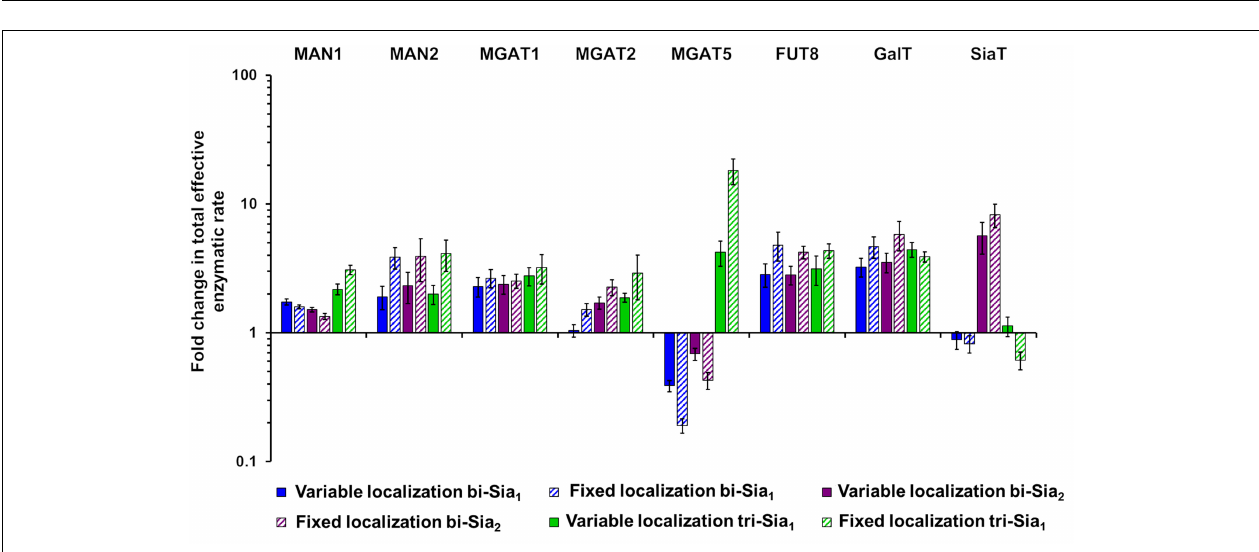
FIGURE 6 | Total enzymatic rate changes to maximize relative abundance of target glycans. Percentage changes in total effective enzymatic rates following fitting to maximize the abundance of bi-Sia 1 (blue), bi-Sia 2 (red), and tri-Sia 1 (green) fitted with variable enzyme localization (solid) and fixed enzyme localization (striped) relative to the parameters predicted for the WT HEK293T cell profile. Total effective enzymatic rates obtained from the different fits were adjusted to ensure that the transit time in each case matched that of the WT HEK293T